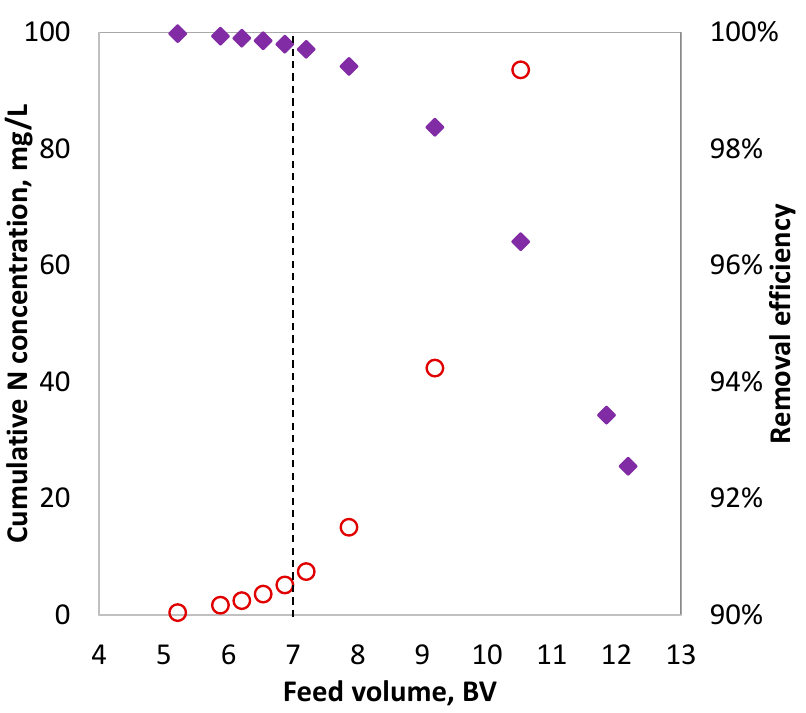
Figure 4. Ammonium removal during cycle 7 in laboratory-scale cyclic runs. Open circles: cumulative N concentration; solid diamonds: removal efficiency. CS16GC in K + form, V bed = 35.34 mL, Q = 4 BV/h at 60 °C, loading: 12 BV 0.179 mol/L NH 4 Ac, washing: 4 BV water, regeneration: 3 BV 2 mol/L K 3 PO 4 , second washing: 4 BV water.